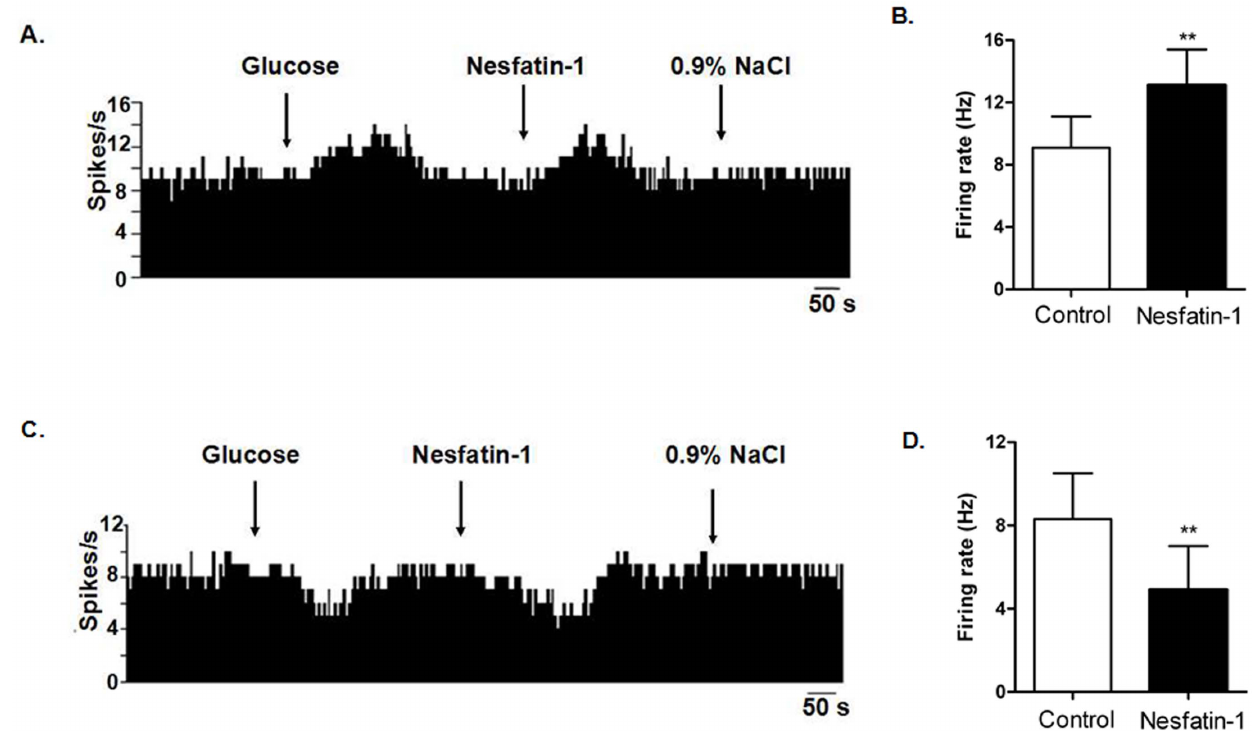
Figure 4. Effect of nesfatin-1 on glucosensing neurons in the dorsal vagal complex (DVC). (A). A GE-neuron was excited by nesfatin-1.The first arrow indicates 5 mM glucose, the second arrow indicates nesfatin-1 (1.5 6 10 2 8 M), and the third arrow indicates 0.9% NaCl-treated control. (B). Changes in firing rate after application of nesfatin-1 (n=20, **P , 0.01). (C). A GI-neuron was inhibited by nesfatin-1. (D). Changes in firing rate after application of nesfatin-1 (n=33, **P , 0.01).